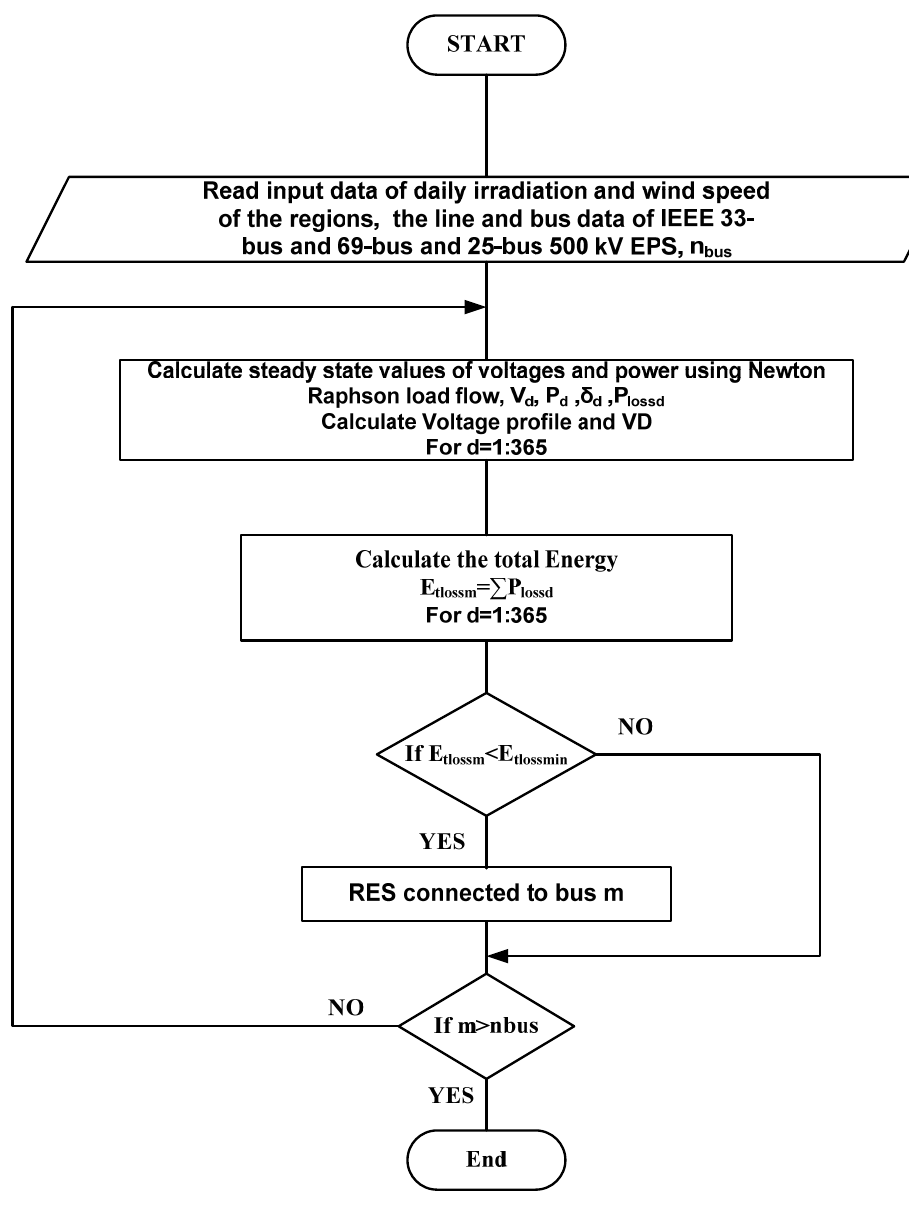
Figure 4. The flowchart of selecting the bus of RES.